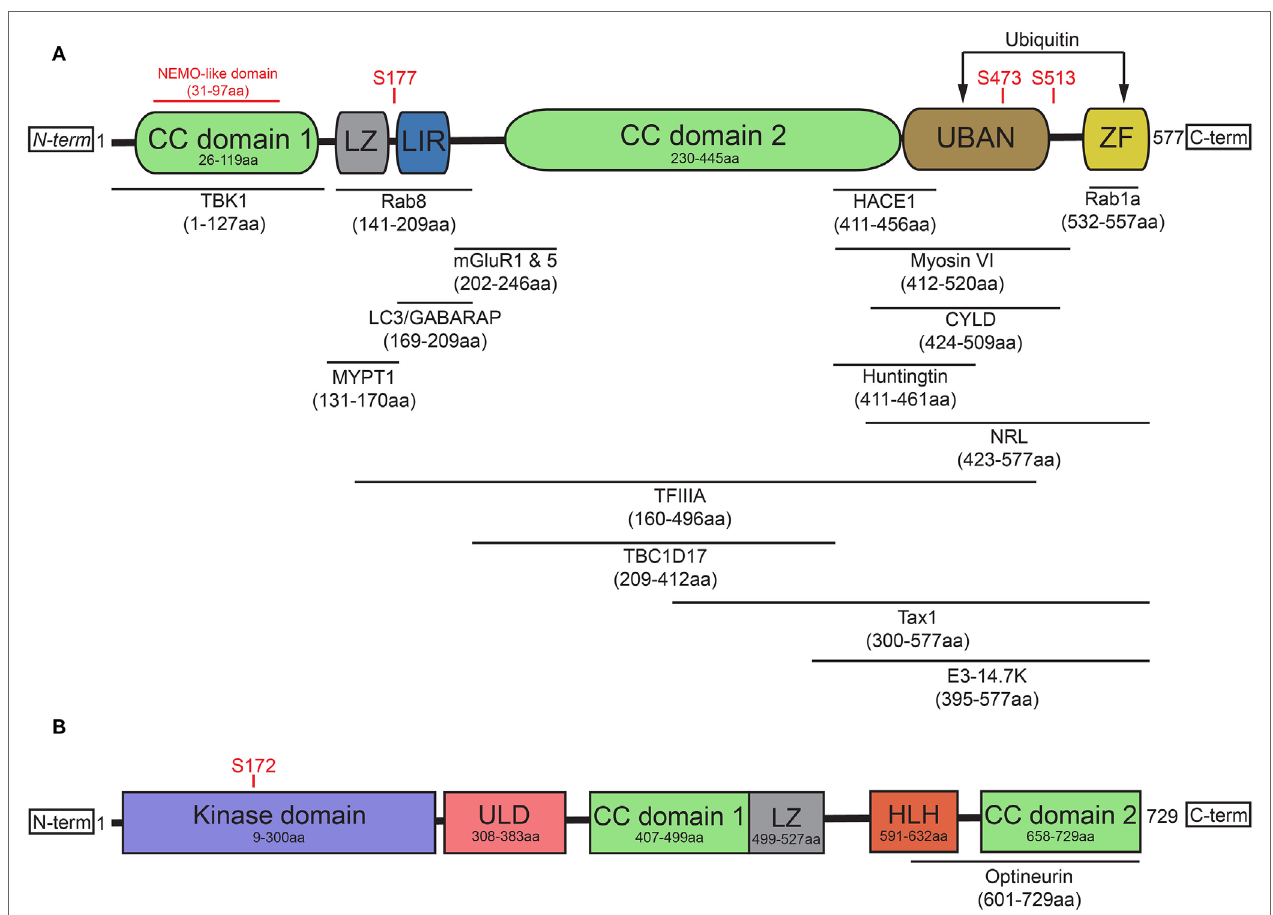
FiGURe 1 | Optineurin and TBK1 both contain multiple structurally distinct domains associated with their regulation, binding, and activity. (A) Optineurin comprises two coiled-coil (CC) domains, a leucine zipper (LZ), an LC3-interacting region (LIR), UBAN domain, and a zinc finger (ZF) domain at it C-terminus. To date, a number of studies have identified the interacting regions of optineurin with its binding partners, defined in this figure. Serine phosphorylation sites are represented that regulate optineurin’s LC3-binding or ubiquitin-binding capacity. (B) TBK1 comprises a kinase domain, a ubiquitin-like domain (ULD), two CC domains, a LZ, and a helix-loop-helix (HLH) motif. Serine 172 represents the site that regulates TBK1’s kinase activity. TBK1 interacts with optineurin via its C-terminal HLH and CC